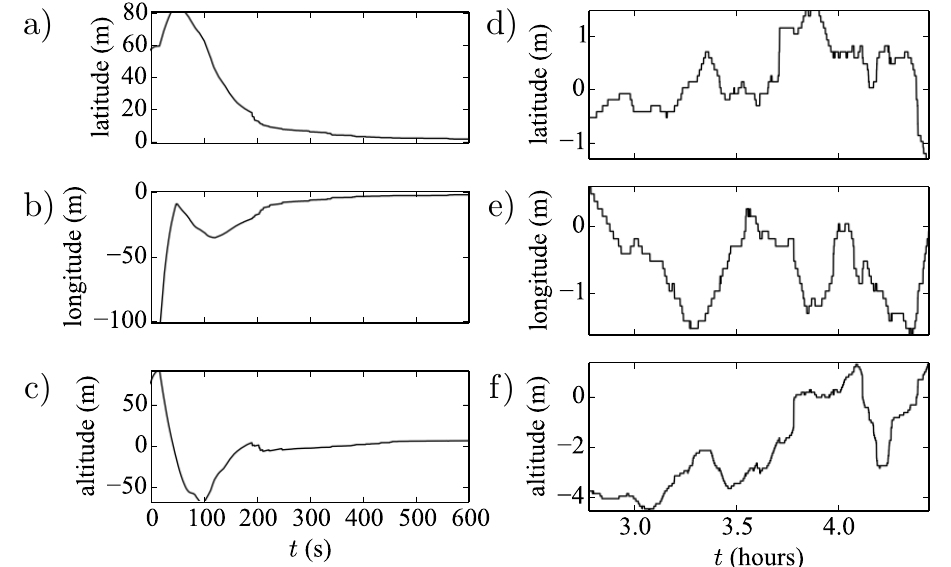
Figure 2. ( a – c ) First 600 s of GPS time-series residuals taken at Port Douglas, illustrating the rapid initial convergence towards the “true” value; ( d – f ) corresponding later GPS time-series residuals illustrating the time-correlated deviations from the “true” value (zero). The apparent position quantization due to rounding is also visible.